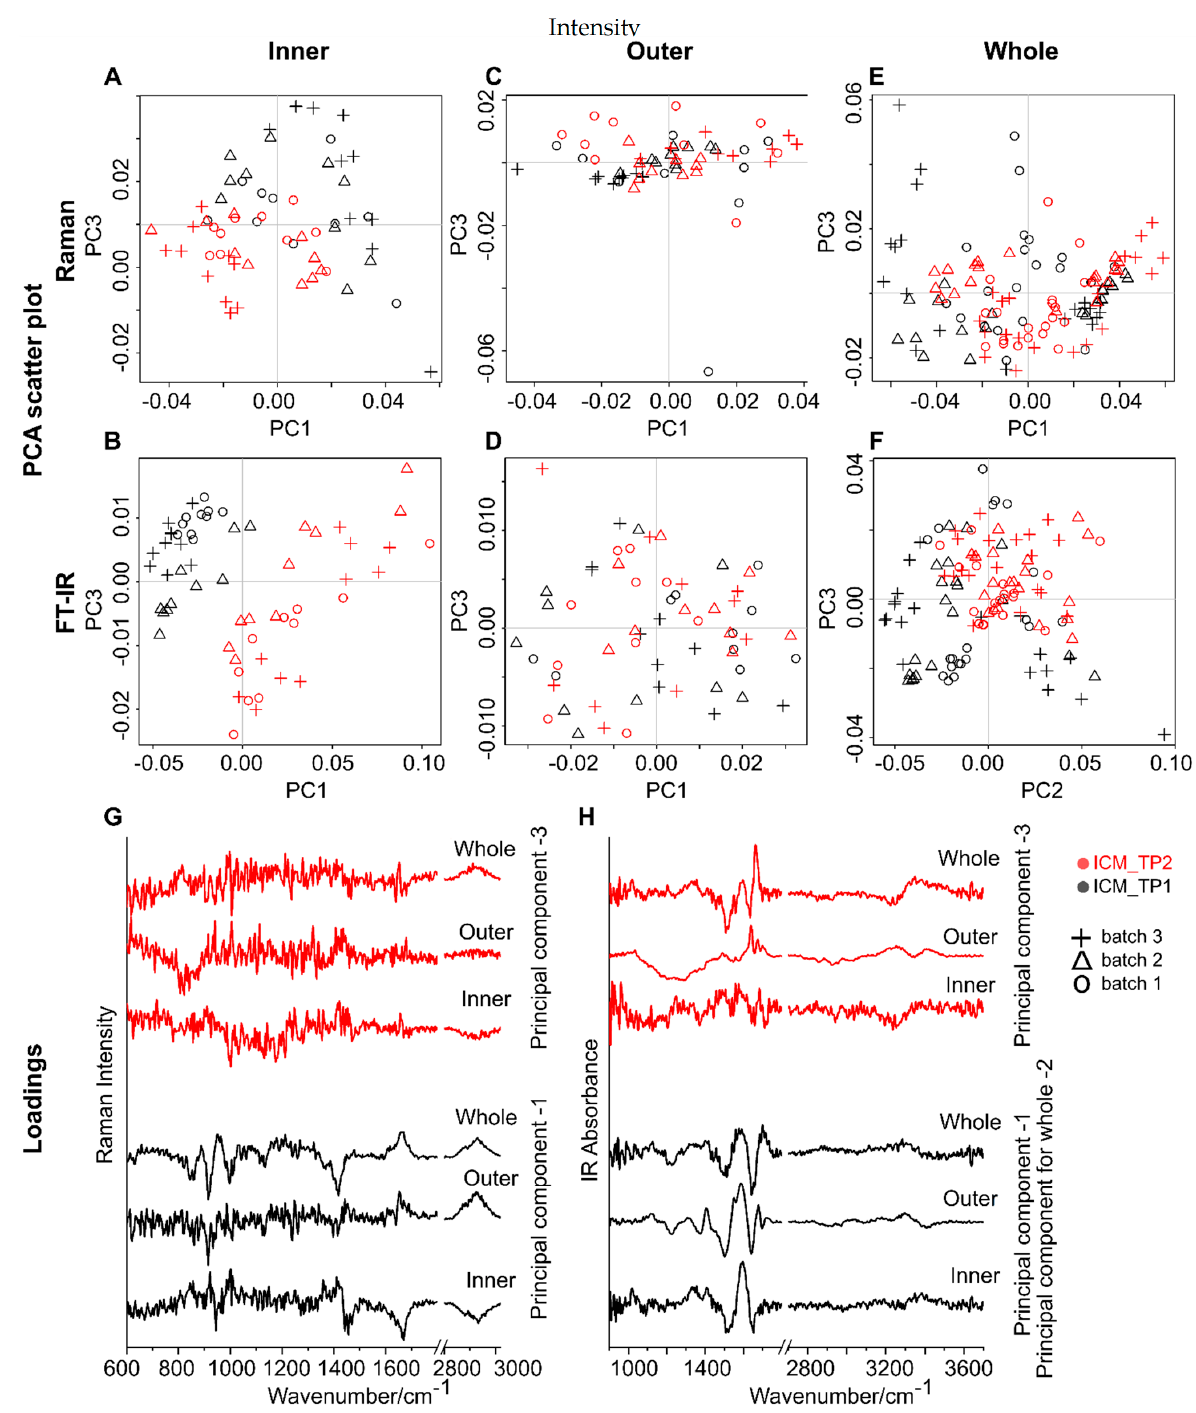
Figure 5. PCA analysis of Raman (first row) and FT-IR spectra (second row) collected from ( A , B ) inner region and ( C , D ) outer-ring regions from the plasma of the ICM patient ( n = 1). ( E , F ) combined analysis of the vibrational spectra collected from both inner and outer-ring regions. The principal components 1 and 3 of ( G ) Raman and ( H ) FT-IR data. The different time points (TP1 and TP2) of the patient sample collection are color coded, and the experimental replicates are presented as symbols (+, ∆ and o).